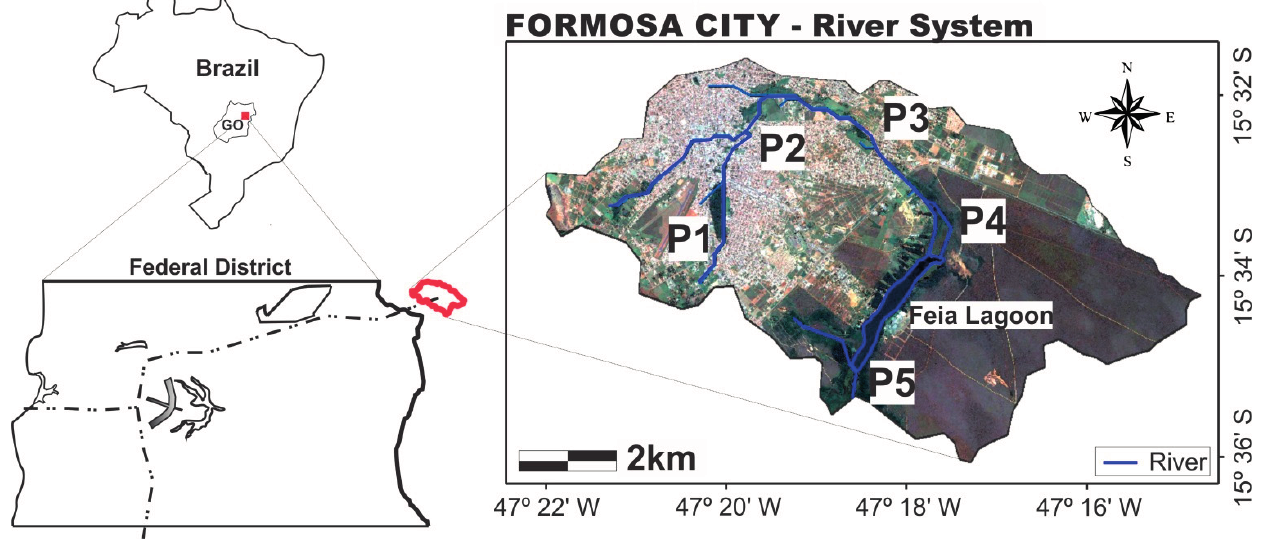
Figure 2 . Map showing the location of the headwaters of the Preto River in Formosa, Goiás, with respective collection points. Source: satellite image (Landsat-8) modified by SPRING 5.0